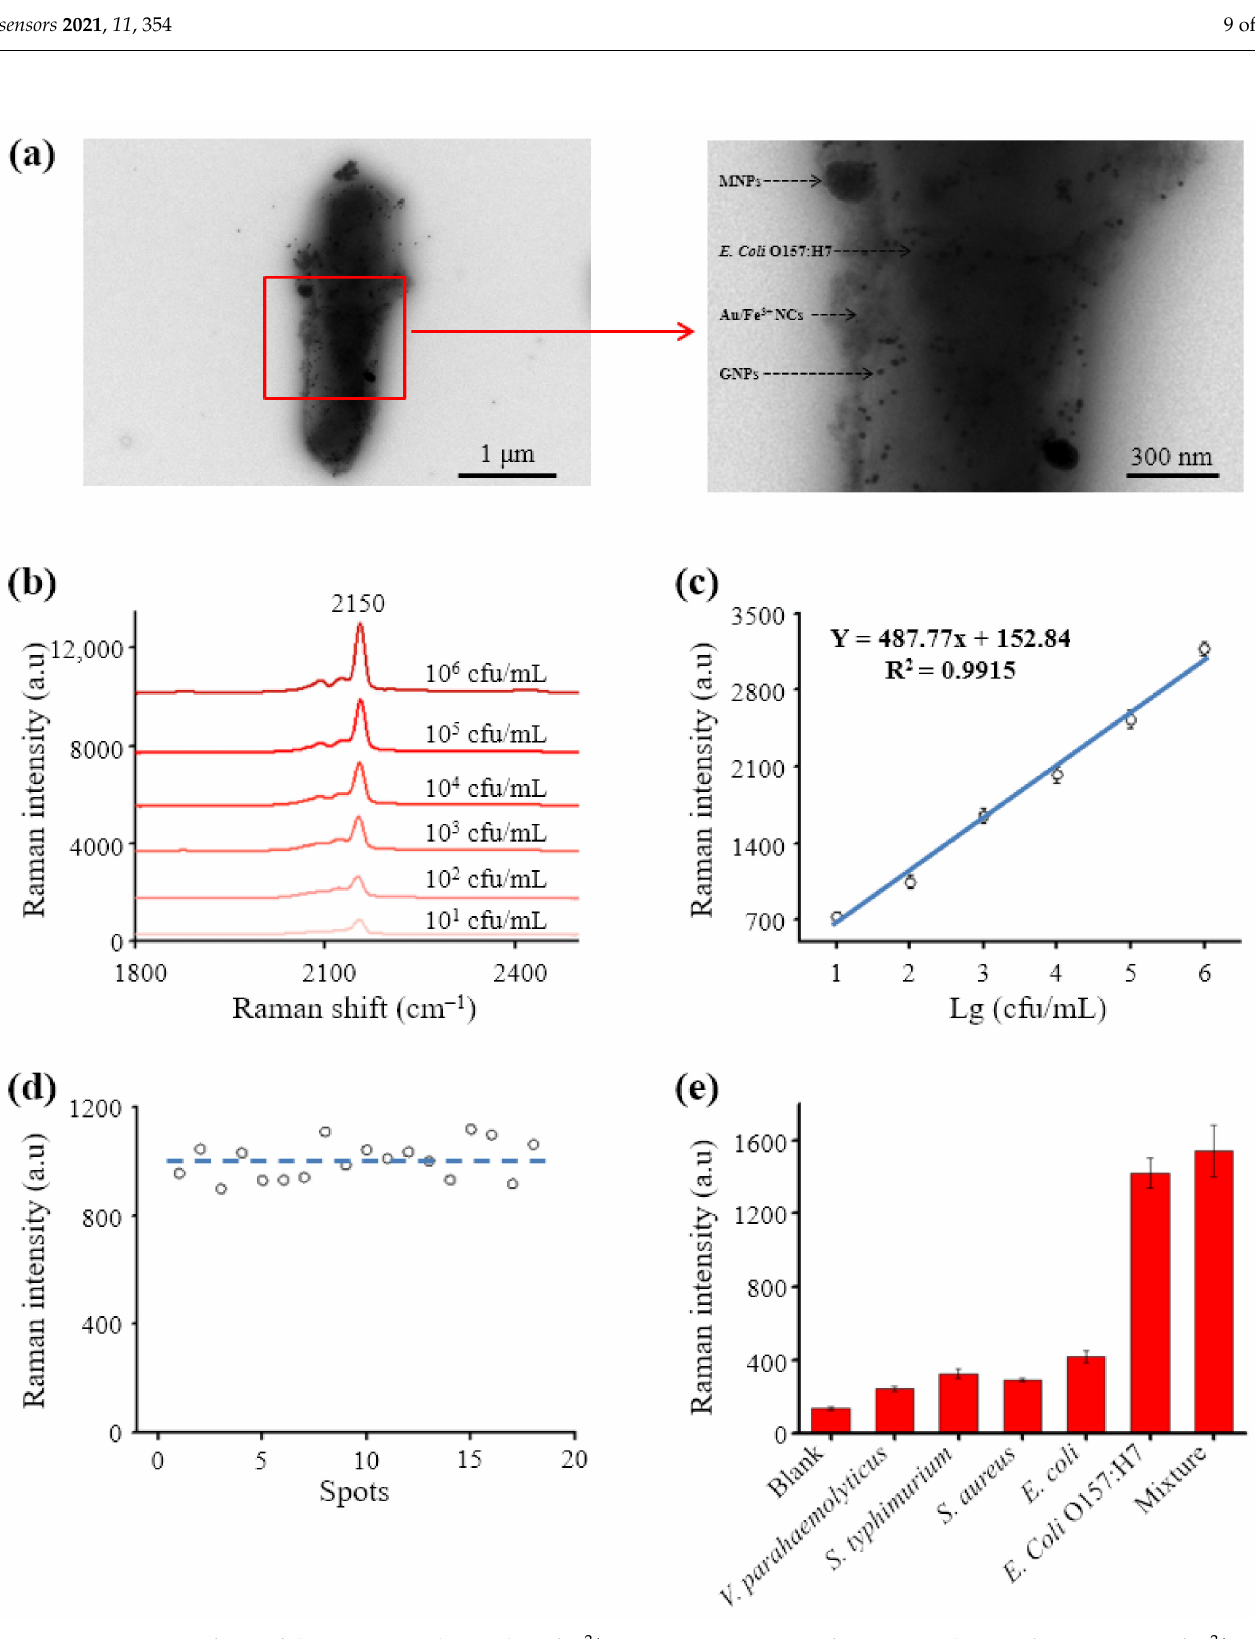
Figure 5. Bio-specificity of the capture probes and Au/Fe 3+ NCs. ( a ) TEM image of capture probe– E. coli O157:H7–Au/Fe 3+ NC sandwich complexes and corresponding magnified image obtained from the square area, ( b ) SERS spectrum for a series of concentrations of E. coli . O157:H7, ( c ) linear correlation between the logarithms of E. coli . O157:H7 concentration and SERS peak intensities at 2150 cm − 1 , ( d ) Raman intensities of 18 separately measured random samples from a 10 2 cfu/mL suspension of E. coli . O157:H7, and ( e ) Raman intensities for E. coli O157:H7, three interfering bacteria, and their